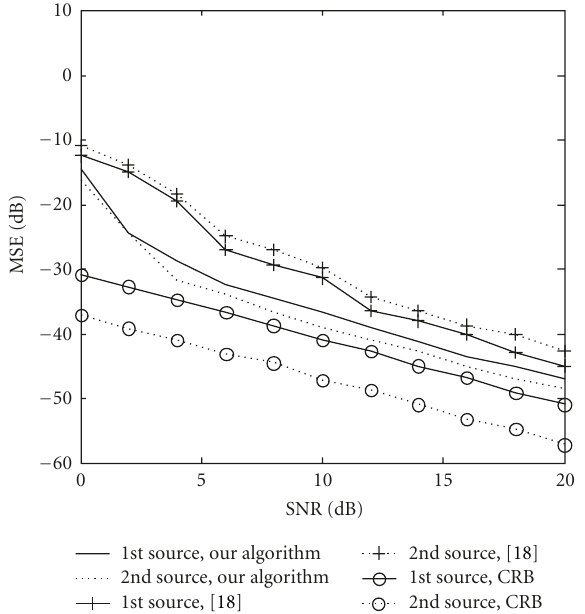
Figure 6: Estimation MSE of the frequencies versus snapshot num-